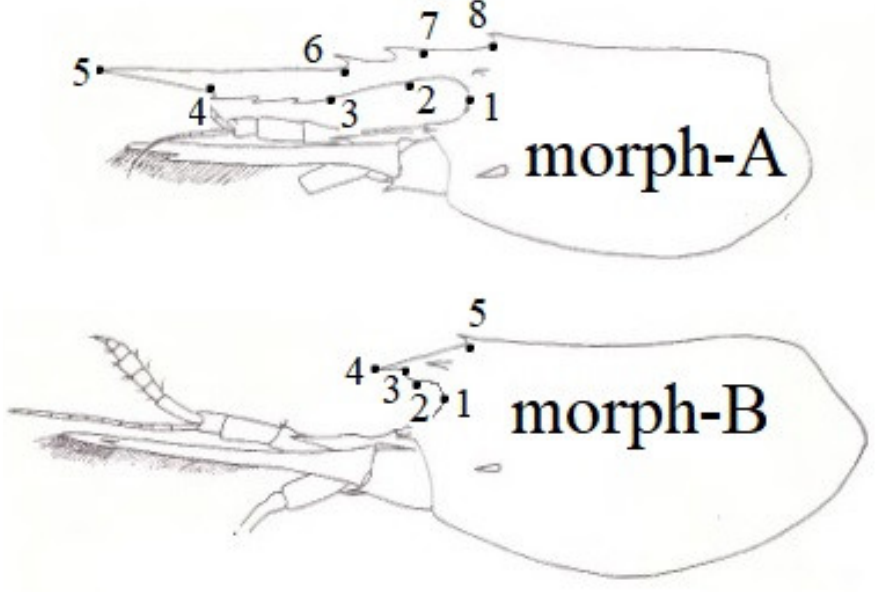
Figure 2. Left side of the rostrum of Hippolyte sapphica morphotypes A and B with the configuration of the 8 and 5 landmarks, respectively for each morphotype (modified by [12]). Morph-A, 1: the rear-end of orbital margin, 2: the ventral upper rostral point, 3: the ventral posterior dentition end-point, 4: the ventral anterior dentition end-point, 5: the anterior most rostral tip, 6: the dorsal anterior dentition end-point, 7: the dorsal posterior dentition end-point, 8: the postorbital tooth. Morph-B, 1: the rear-end of orbital margin, 2: the ventral lowest rostral point, 3: the ventral upper rostral point, 4: the anterior most rostral tip, 5: the postorbital tooth.